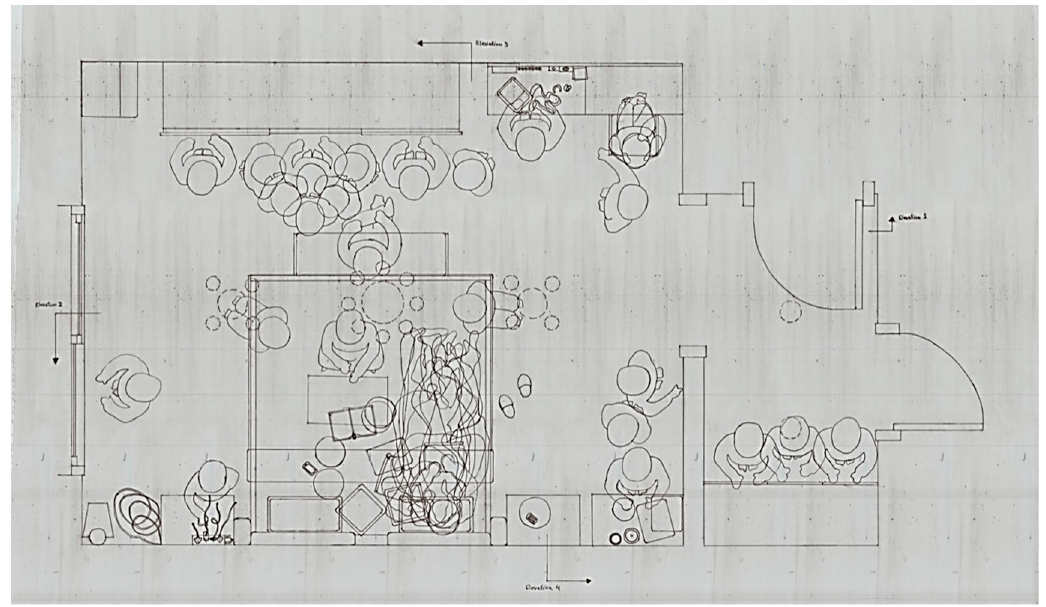
Figure 17. Bedroom space analysis representing and communicating the current space use. Work sample from Project Part I. Courtesy: Ameera Al Marzooqi.